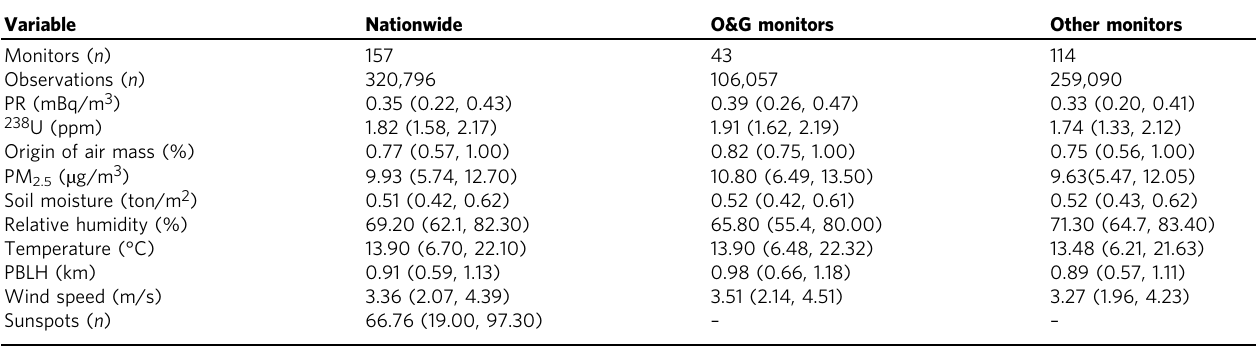
Continuous environmental factors are summarized as the mean and the interquartile range (from 25th percentile to 75th percentile). The unit of the gross-beta radiation is millibecquerel (mBq). 1mBq/m 3 is equal to 1×10 − 3 Bq/m 3 . 1mBq/m 3 is also equal to 0.027